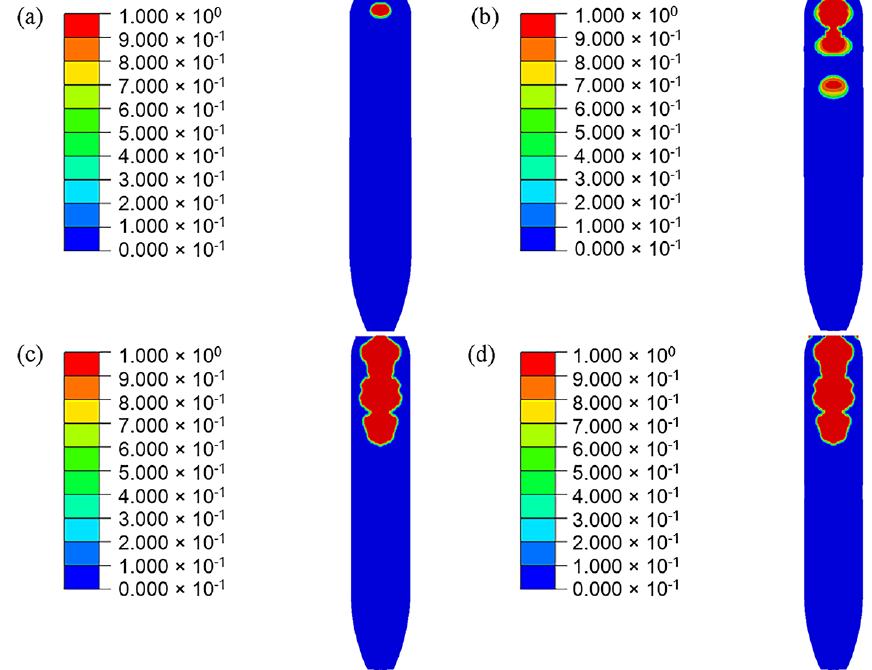
Figure 15. Evolution of the microcrack damage of the PBX1314 main explosive. ( a ) 500 μ s. ( b ) 1200 μ s. ( c ) 2200 μ s. ( d ) 3400 μ s.